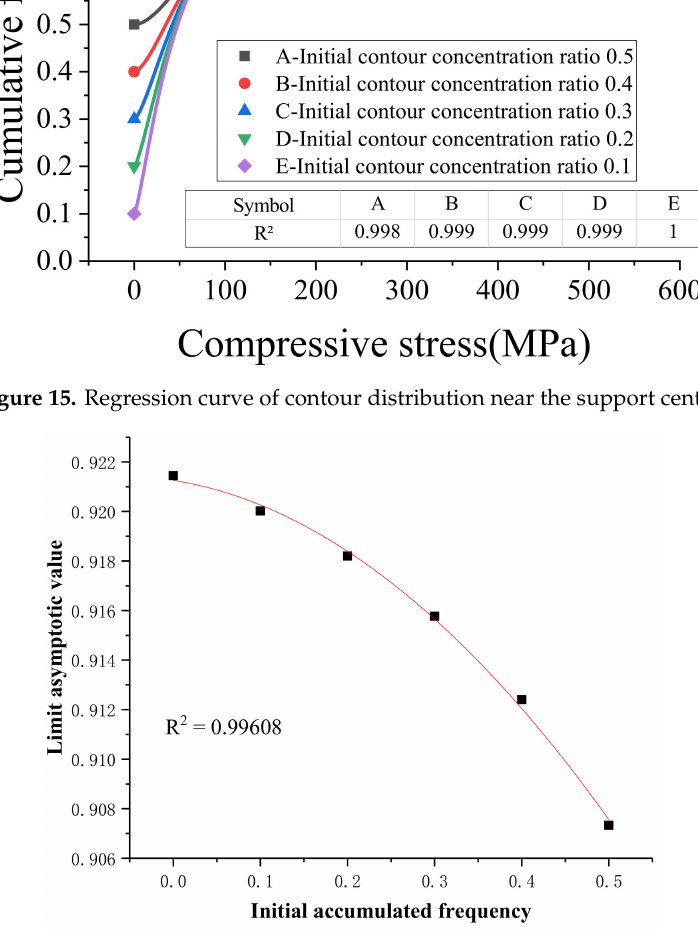
Figure 16. Relationship between the initial accumulated frequency of apparent profile and its corresponding limit asymptotic